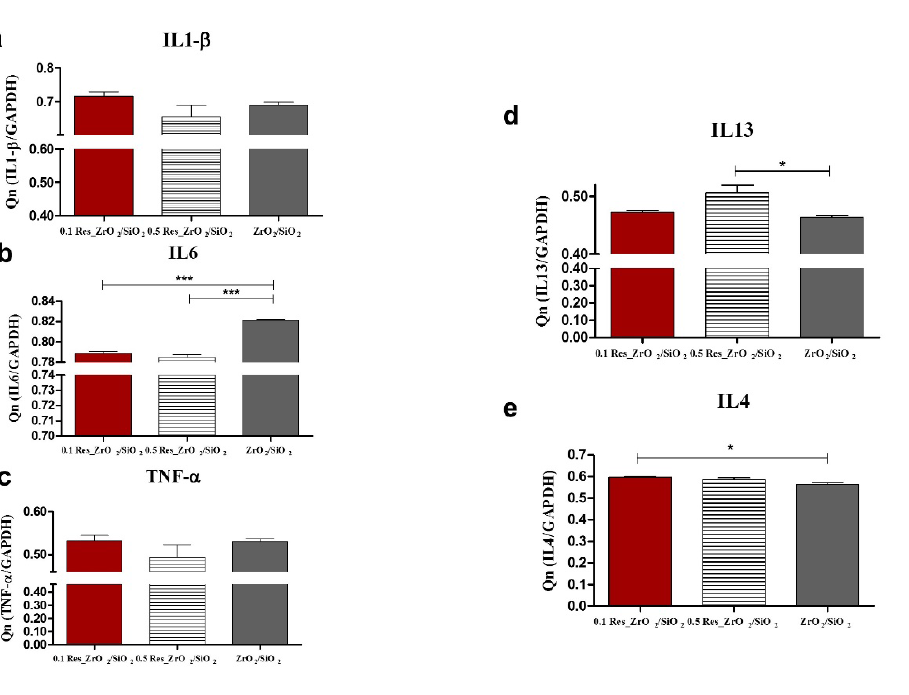
Figure 9: Expression level of the IL1-β (a), IL6 (b) and TNF-α (c) genes in order to assess the level of proinflammatory cytokines. Moreover, expression level of the IL13 (a) and IL4 (c) genes was performed to assess the level of anti-inflammatory cytokines. Results expressed as mean ± SD *pvalue<0.05,.